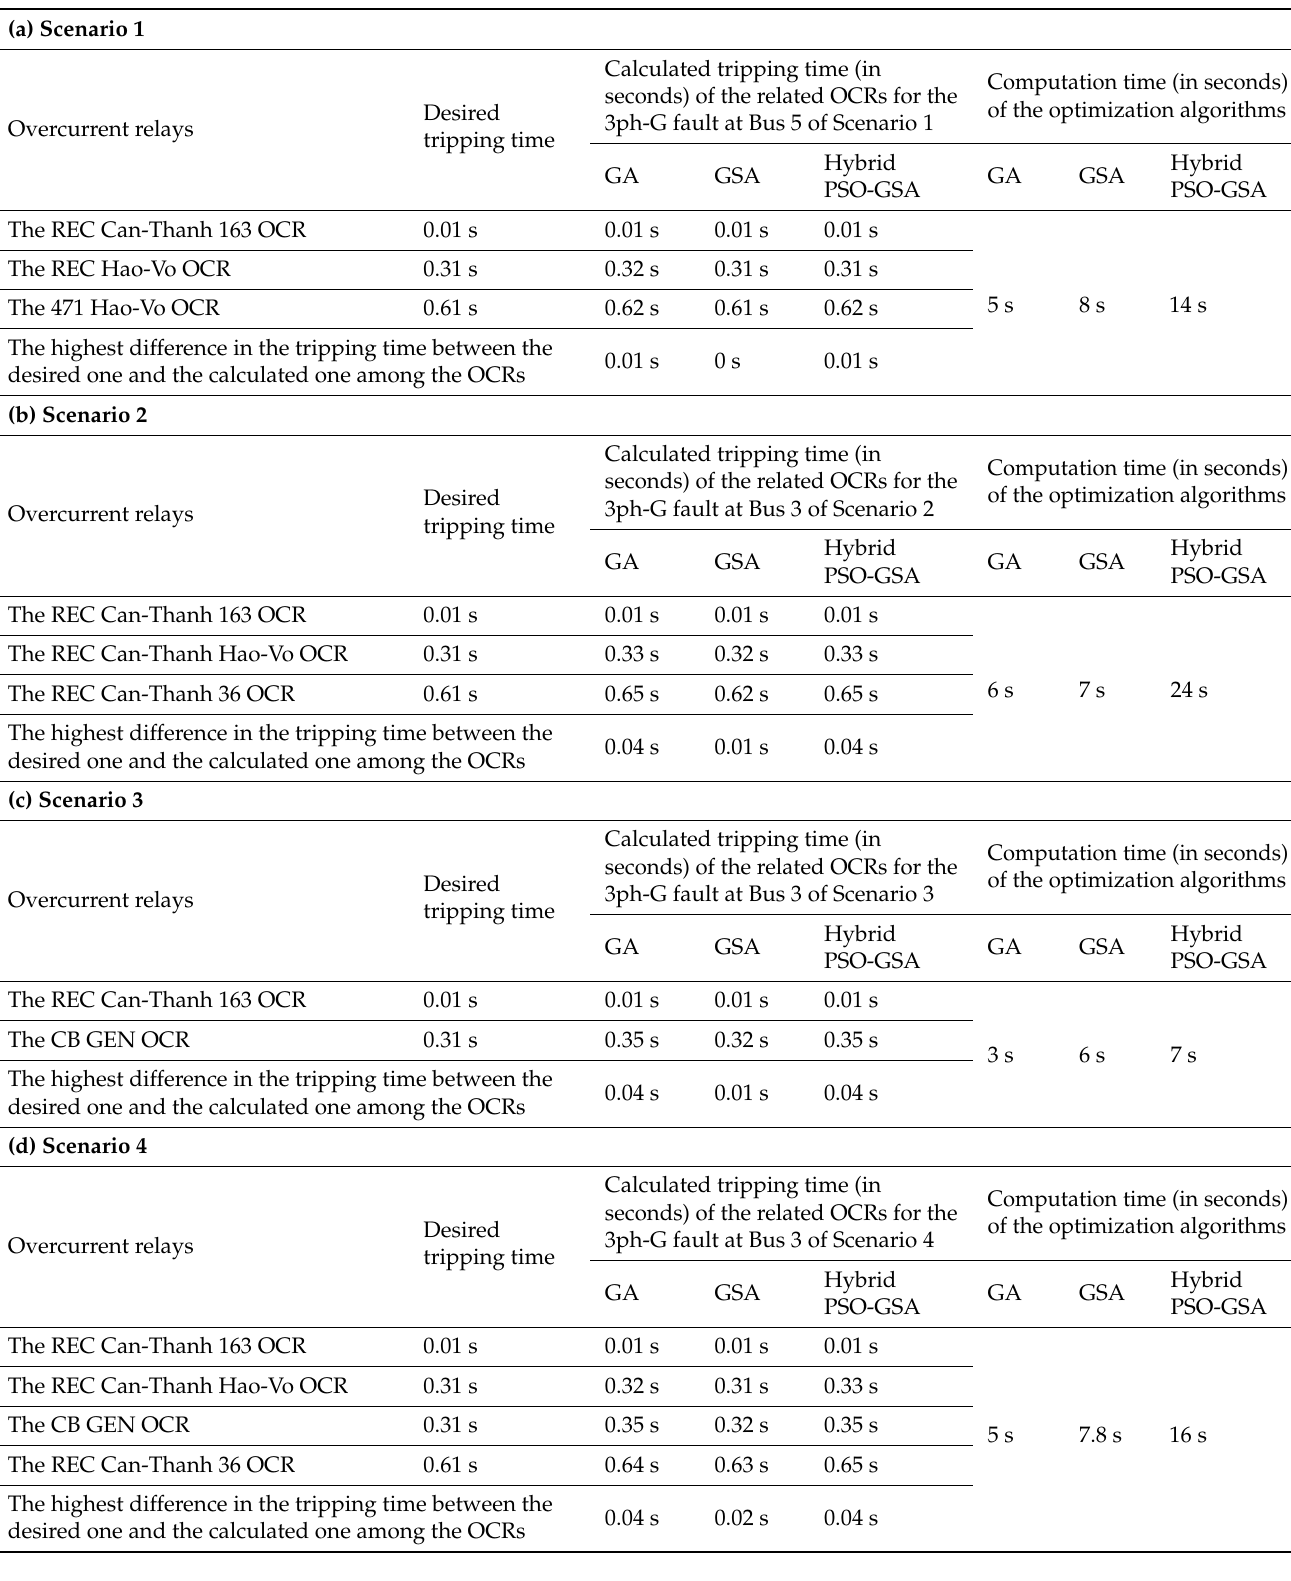
Table 8. Comparison in the calculated tripping time of the related OCRs and the computation time of GA, GSA and hybrid PSO-GSA algorithms for Scenarios 1, 2, 3 and